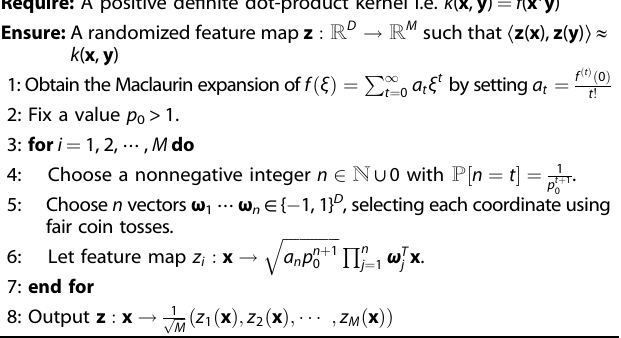
Algorithm 2. RFM